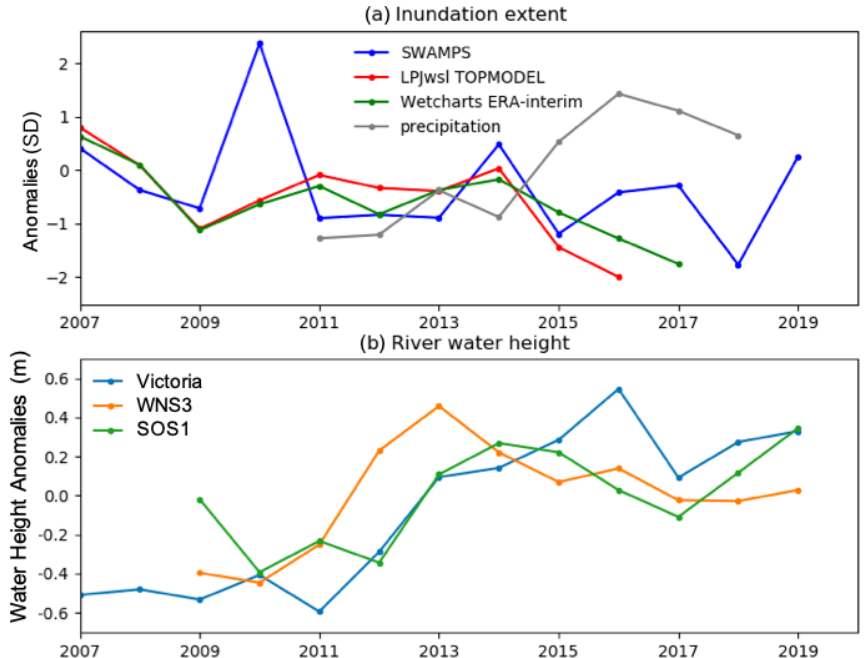
Figure 4. SSWR inundation extent estimates. (a) Annual anomalies of inundation extent estimates from SWAMPS, TOPMODEL and Wetcharts (ERA-Interim) used in process models, as well as ERA5 precipitation, expressed in units of the standard deviation of the respective annualized time series. (b) Water height anomalies for the altimetry sites in Lake Victoria as well as the White Nile (WNS3) and Sobat (SOS1) rivers from the Hydroweb database. Locations of these altimetry sites are given in Fig. 1. Here we only use the altimetry sites which have sufficiently long temporal coverage that includes